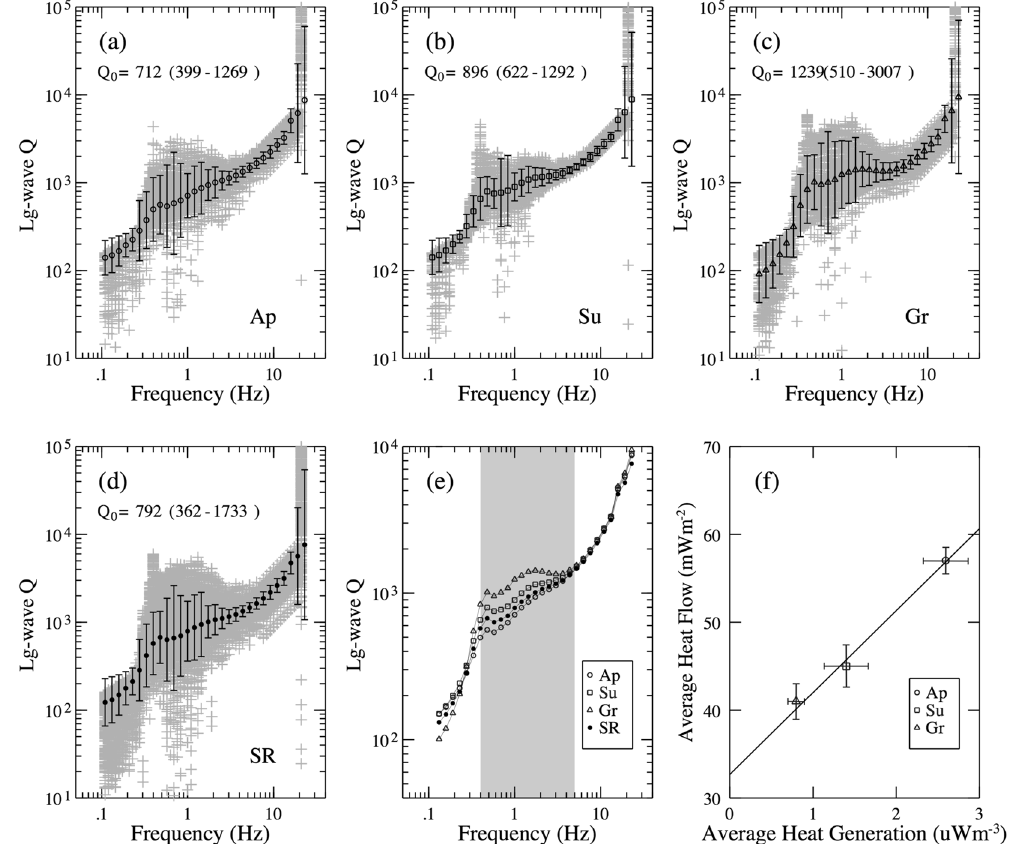
Figure 9. Average Q Lg at 1 Hz for Appalachians ( a ), Superior ( b ), Grenville ( c ) provinces, entire area ( d ), and Q variation as a function of frequency for these regions ( e ). Mean heat flow and heat production for these geological provinces ( f ) average Q vs the average heat flow 73,85